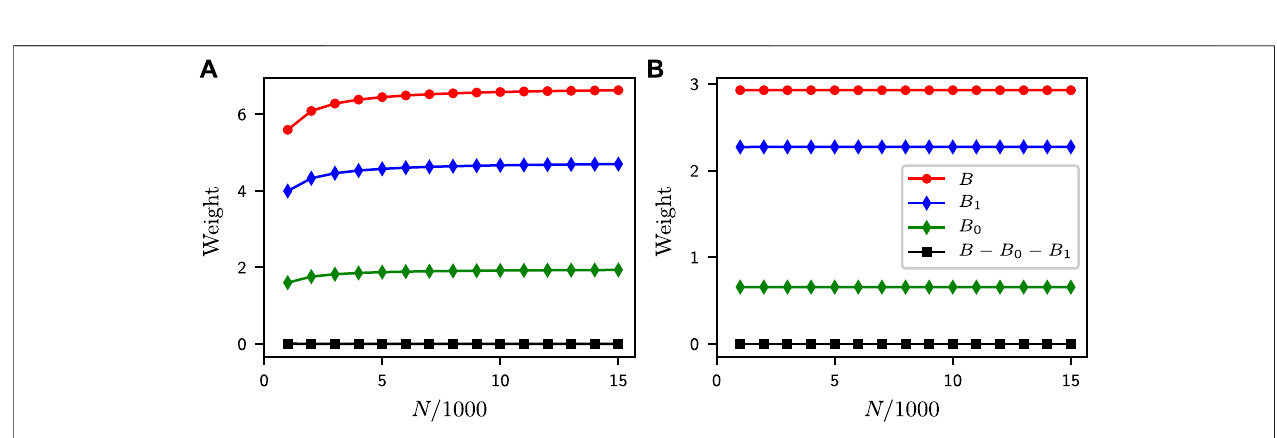
FIGURE4| Weightsofground-state twisted vectorin theground and low-lying excited states asfunctionsofsystem size N at q =2.1for ferromagnetic interaction (A) and at q = 0.2 for antiferromagnetic interaction (B) .